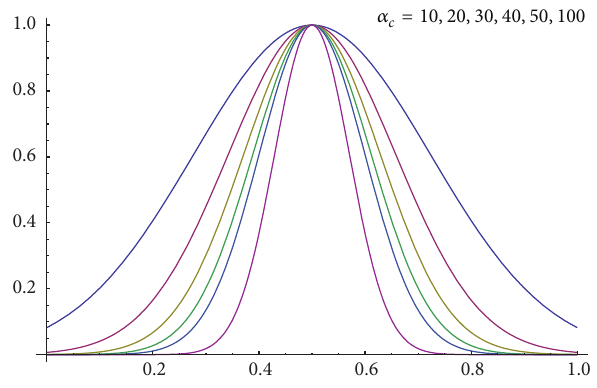
Figure 1: Weight function in the support domain.